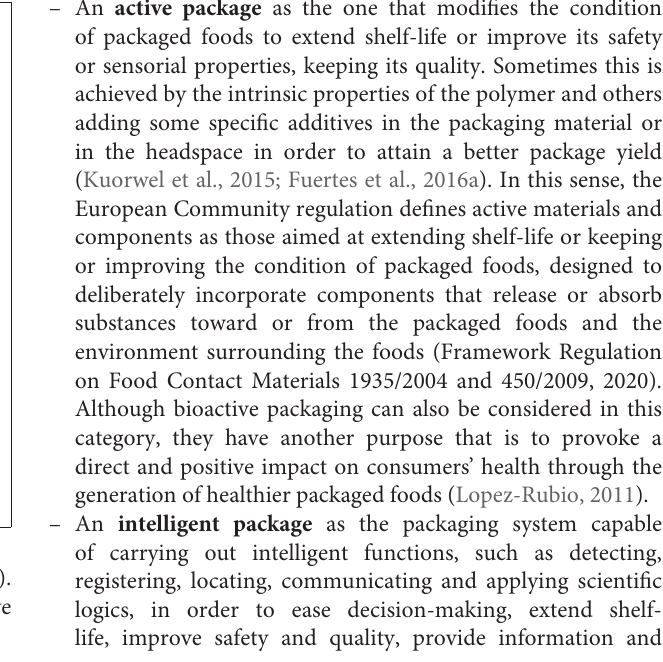
main categories: active or intelligent packaging (Kerry,